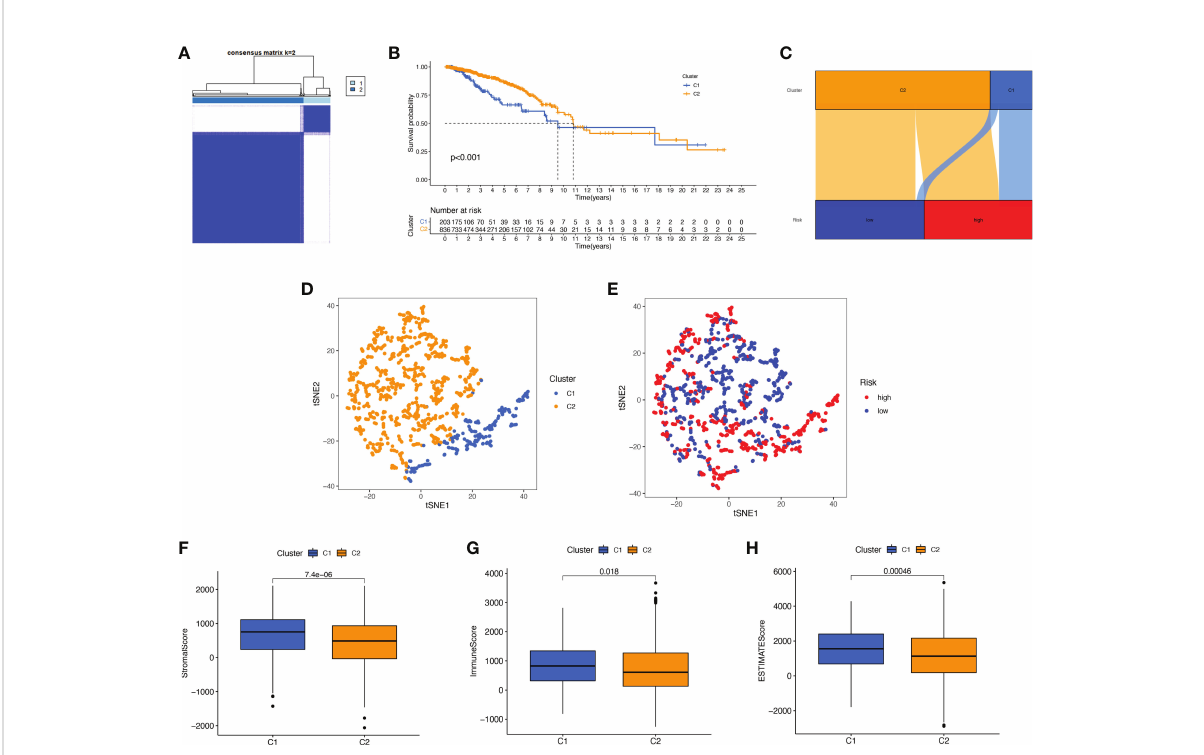
FIGURE 7 Survival, tSNE, and tumor microenvironment analysis for different clusters. (A) The best consensus matrix at k = 2. (B) Survival curves of BC patients in the two clusters. (C) Sankey diagram showing the distribution of risk scores between different clusters. (D) tSNE analysis of the two different clusters. (E) tSNE analysis of the high- and low-risk groups. (F – H) Box plots of StromalScore (F) , ImmuneScore (G) , and ESTIMATEScore (H) in different clusters. tSNE, t-Distributed Stochastic Neighbor